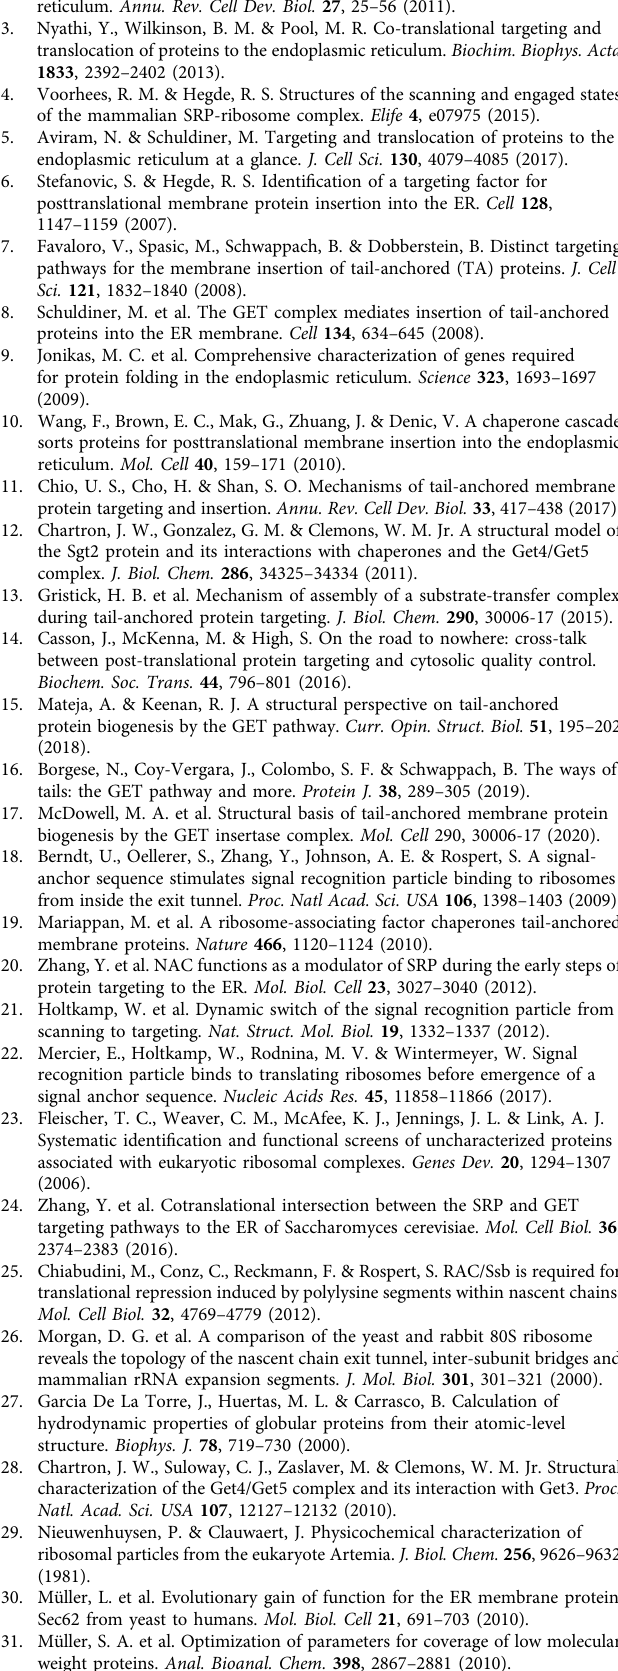
Figure 1c: n = 3 for each concentration, except for the measurements at 0.1 µM 80S ribosome concentration, which was n = 2. Figure 1d: n = 6. Figure 2b – d: n = 2. Figure 3b: n = 2. Figure 4b: n = 2. Figure 4c: n = 3. Figure. 4d, e: n = 2. Figure. 4f, g: wild type and Δ srp54 n = 5, wild type + His 6 Get4/Get5 and Δ srp54 + His 6 Get4/ Get5 n = 2. Figure 5a: n = 1. Figure. 5b – d: n = 2. Figure 5e: n = 3. Figure 6a: n = 3. Figure. 6c – f: n = 2. Supplementary Fig. 1: n = 2. Supplementary Fig. 2a, b: n = 2. Supplementary Fig. 2c: n = 2 (technical replicates of LC-MS). Supplementary Fig. 3a – e: n = 1. Supplementary Fig. 3f: n = 2. Supplementary Fig. 4c, 4d, and 4f: n = 1. Supplementary Fig. 4e, j, and 4k: n = 2. Supplementary Fig. 5b – d, 5g, and 5h: n = 2. Miscellaneous . Immunoblots were developed using an ECL camera (Fusion Pulse 6, Vilber). Autoradiographs were analyzed and quanti fi ed with a Typhoon